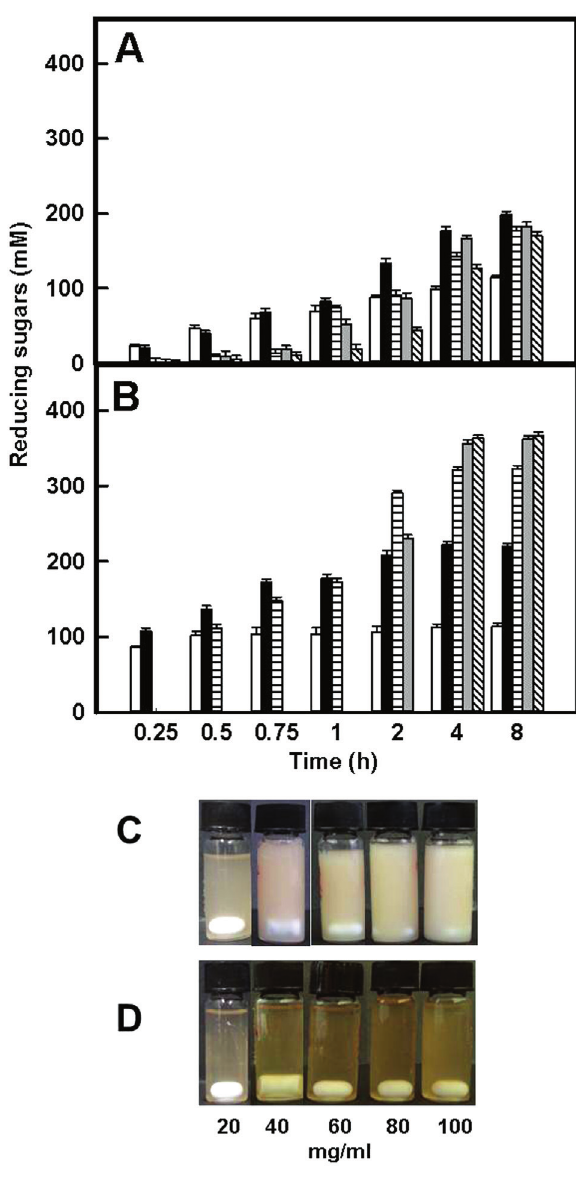
Figure 5 Time course profiles of reducing sugar concentrations obtained by the combined action of cellulase (Celluclast 1.5L, 4.6 mg/ml of reaction medium) and cellobiase (Novozyme 188, 1.4 mg/ml of reaction medium), using different substrate concen- trations (20 mg/ml, white; 40 mg/ml, black; 60 mg/ml, horizontal lines; 80 mg/ml, gray; 100 mg/ml, slant lines) of unpretreated (A) and pretreated (B) paper as substrate in citrate buffer pH 4.8 at 50 ° C. (C) Pictures of the reaction medium after 8 h of hydrolysis of unpretreated (C) and pretreated (D) paper.